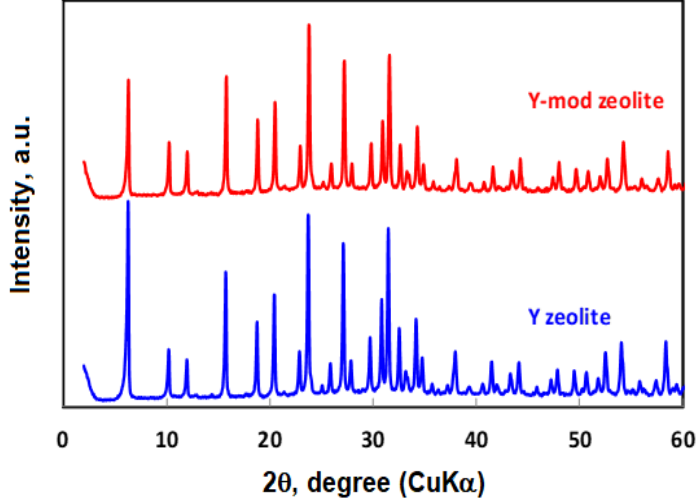
Figure 1. XRD of calcined Y and Y-mod zeolites. Table 1. Textural properties of the catalysts and supports studied in this